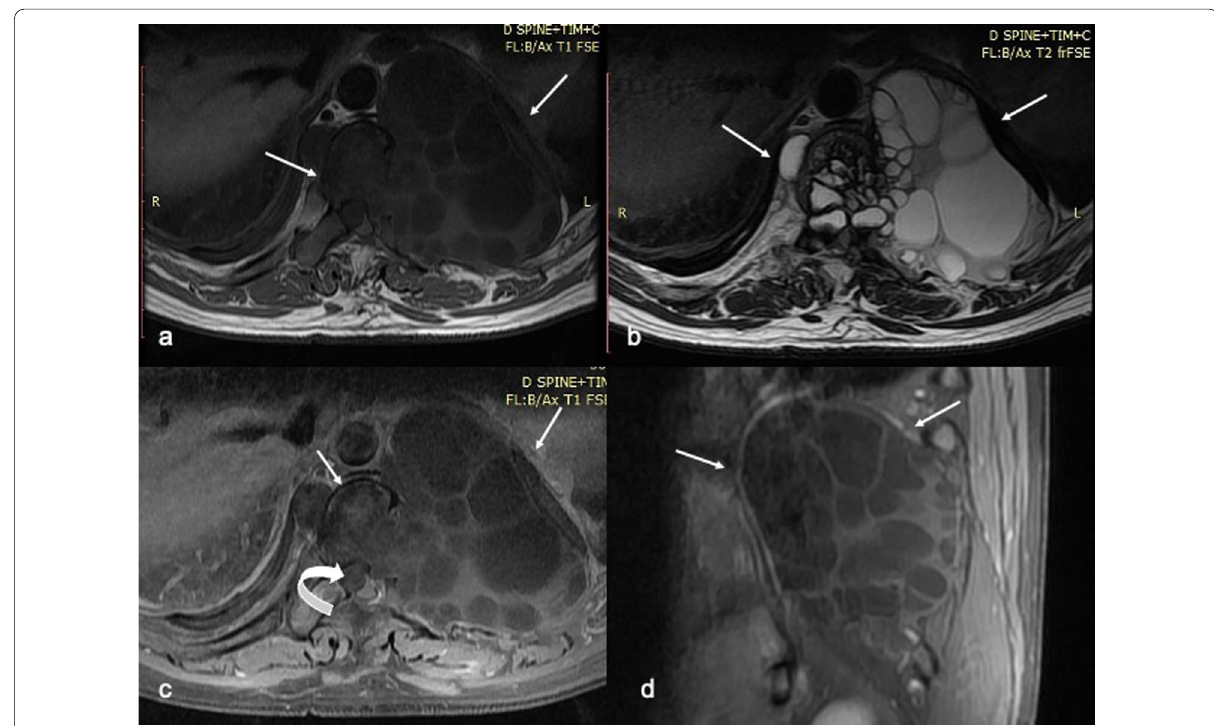
Fig. 2 MRI of dorsal spine in axial plane shows a large multiloculated cystic lesion (white arrow) with extension in adjacent paravertebral soft tissue (left > right) and spinal canal with cord compression (curved white arrow). The lesion is a hypointense on T1WI and b hyperintense on T2WI. c Fat-suppressed contrast-enhanced axial and d sagittal T1WI shows patchy rim enhancement. Multiple daughter cysts are clearly visible within the